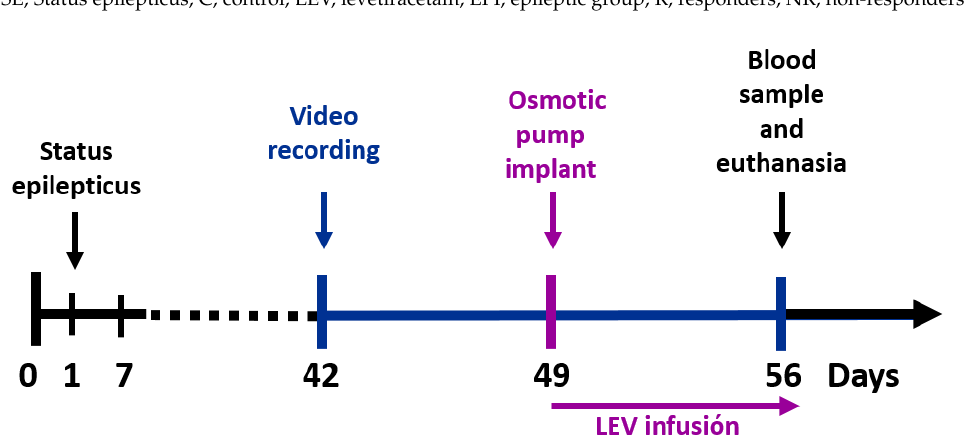
Table 1. Experimental conditions for each group. Group Sample Size (n)